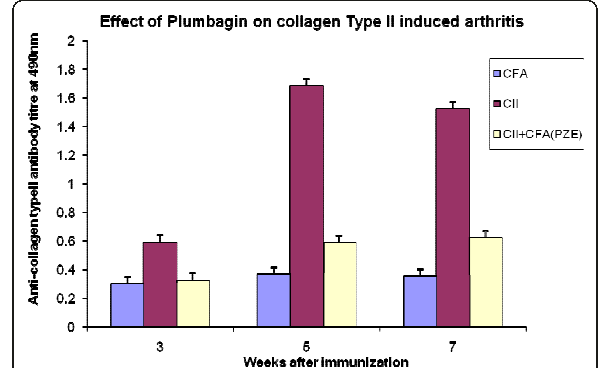
Figure 1 Effect of Plumbagin on collagen type II induced arthritis . Arthritis was induced in two groups (5 per each group) of mice by injecting collagen type II (CII) along with complete Freund ’ s adjuvant (CII+CFA). Control group with CFA alone. Booster dose was given on day 21. One arthritic group was treated with Plumbagin (PZE-6) another treated with olive oil alone. Retroorbital sera were collected at 3, 5, 7 week intervals for the estimation of anti-type II collagen antibody (IgG) by ELISA. Bars represent means±SEM from n = 5. p-value ≤ 0.05 was significant.